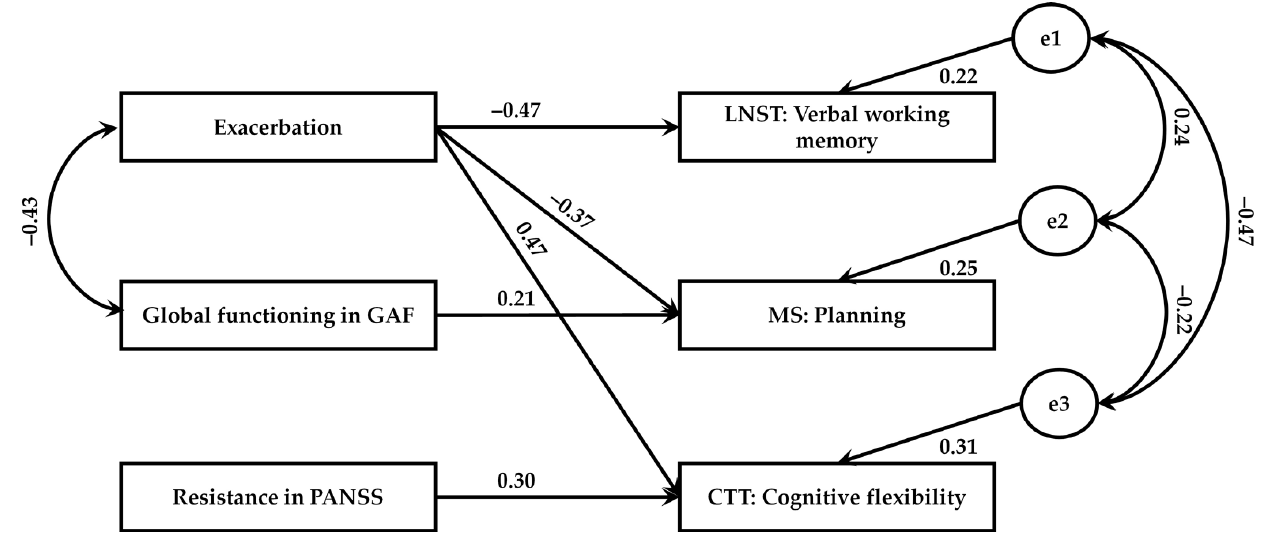
Figure 3. Clinical factors and psychopathological symptoms as predictors of executive functions in DS patients. e1–e3 depict the error term for the dependent variables.